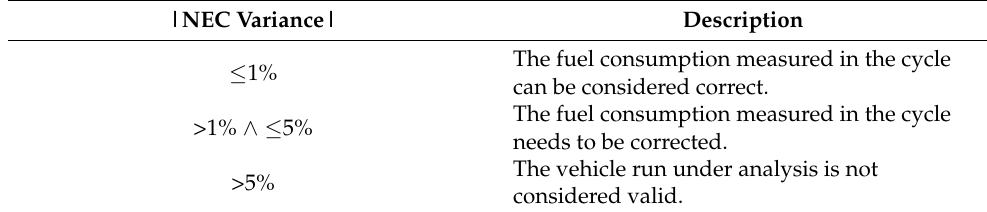
Table 4. Possible |NEC Variance|